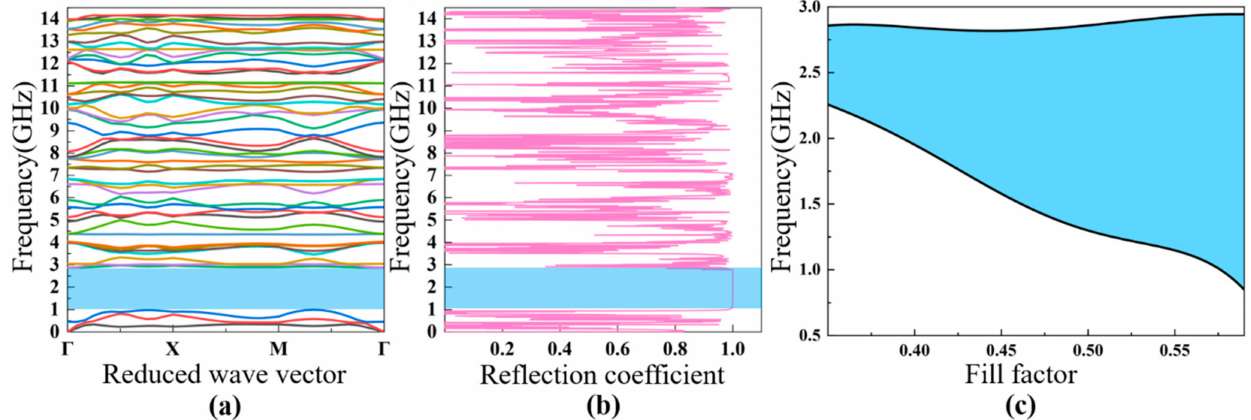
Figure 7. The calculated bandgap diagram ( a ) and reflection coefficient ( b ) of the triangular lattice PhC with the lattice = 0.43 µ m. The dependence of the width of the bandgap on the fill factor ( c parameters of a = 0.9 µ m, d 2